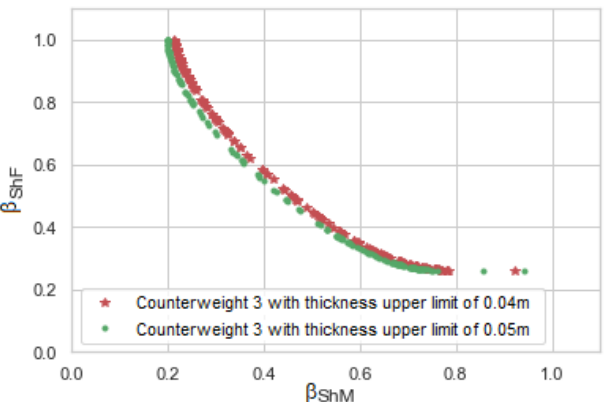
Figure 9. Pareto comparison when changing Counterweight-3 thickness upper